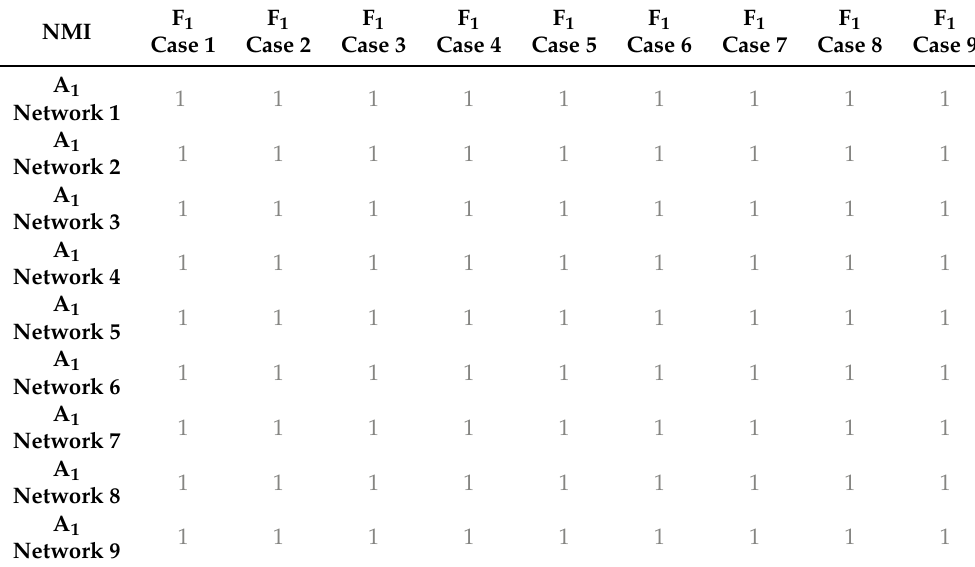
Table 3. NMI. Model 1.